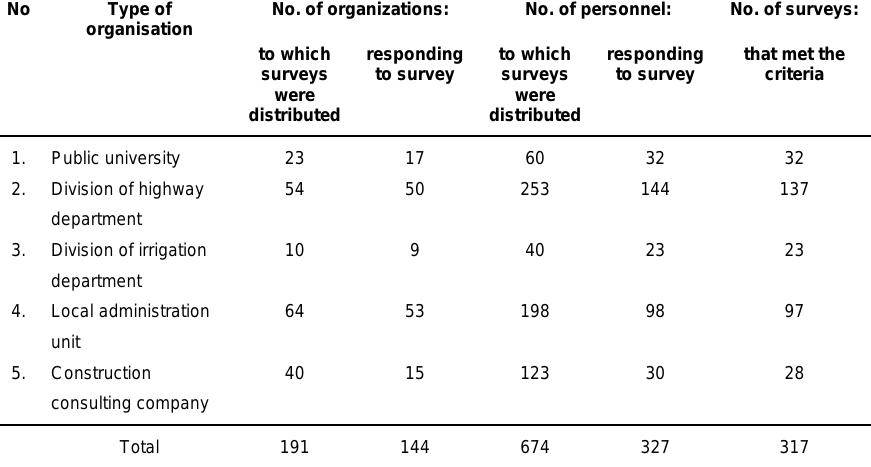
Table 2: List of the proposal attributes and the characteristic of each